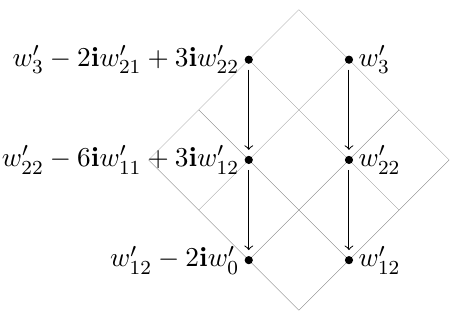
Figure 22 . The Hodge diamond of the mixed Hodge structure ( V; F 0 ; W 1 ), in which each dot near the ( p; q )-site represents a base vector of the corresponding subspace I 0 p;q . The arrows show the action of N 2 . The diamond is clearly of type III 0